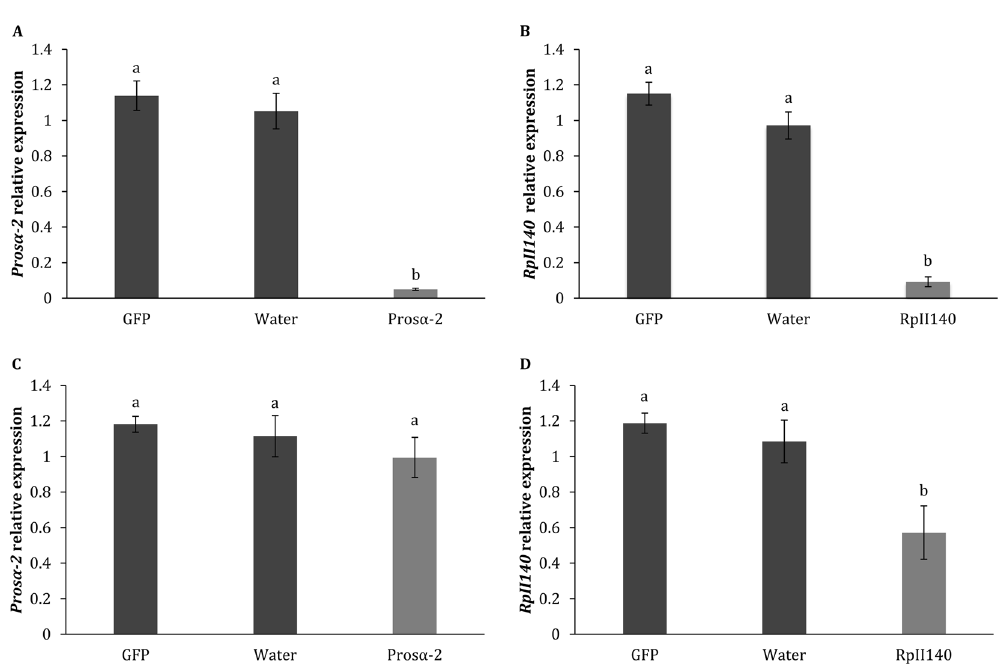
Figure 4. Relative expression of Pros α -2 and RpII140 genes using the recommended reference genes ( α -TUB and RPL12 ) for normalization. Expression of target RNAi genes in insects injected with dsRNA ( A , B ) and insects fed on dsRNA ( C , D ). Data are expressed as mean ± standard deviation of error. Different letters indicate significant differences at P < 0.05 (One-way ANOVA followed by Tukey’s HSD